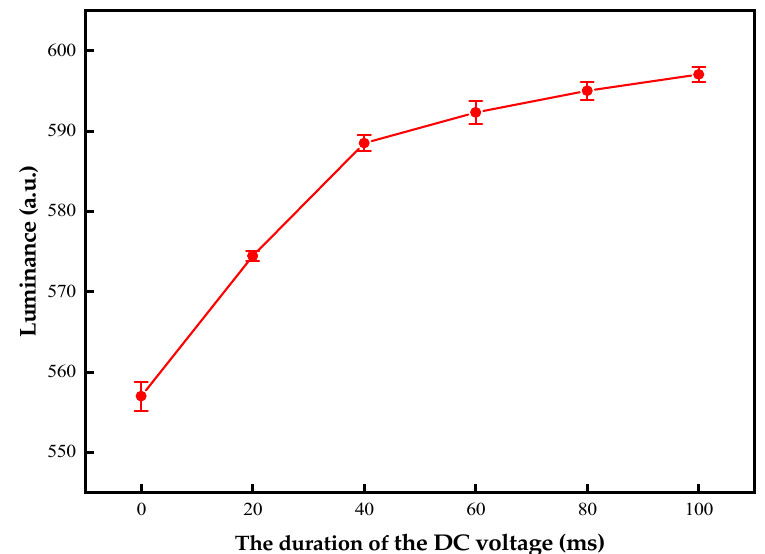
Figure 8. The luminance curve when the EWD was driven by a DC voltage in the DC driving stage. The luminance value was proportional to the driving time. T D was set to 40 ms to shorten the response time.